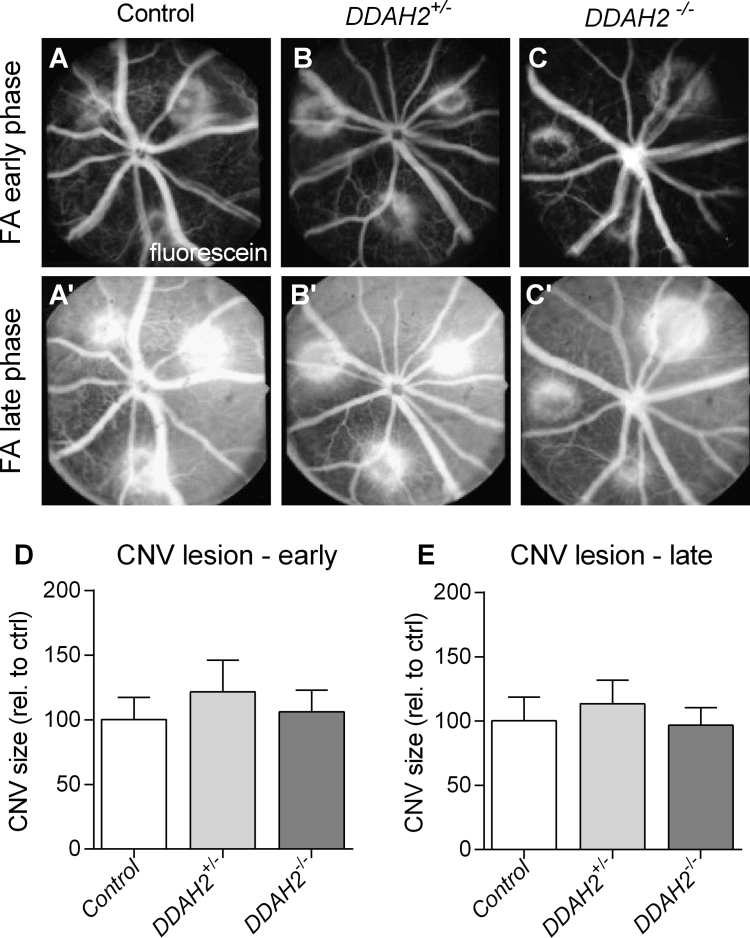
DDAH2 does not contribute to laser induced CNV. A–C). Early and late (‘) fluorescein angiographies of representative CNV lesions of adult DDAH2+/+(control), DDAH2+/−and DDAH2−/− littermates 2 weeks after laser CNV induction. D, E: Mean area of CNV in DDAH2+/+ (control, n = 6), Ddah-2+/− (n = 7) and DDAH2−/− littermates (n = 6) 2 weeks after laser CNV induction (data is presented relative to wildtype littermate controls). Bars represent mean (±SEM).